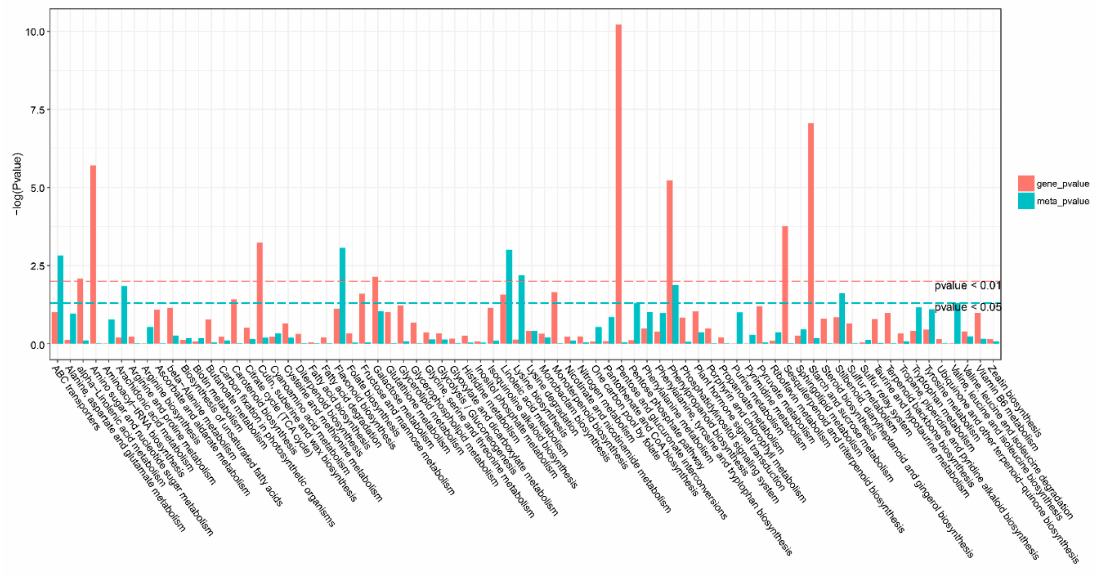
Figure 6. KEGG pathway analysis of differentially expressed genes (DEGs) and differentially ac- cumulated metabolites (DAMs). The horizontal bar is the KEGG pathway, the vertical bar is the enrichment − log10 ( p -value) value, the red in the ordinate represents the enrichment − log10 ( p -value) value of differential genes, the green represents the enrichment − log10 ( p -value) value of differential metabolites, the vertical axis. The higher the coordinate, the smaller the p -value value, and the stronger the